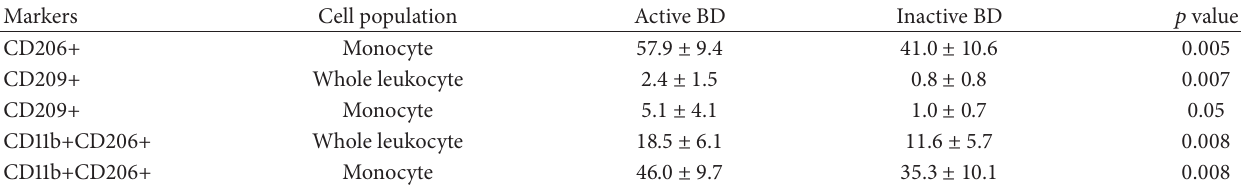
Table 3: The significant changes of PRR between active and inactive Behc¸et’s disease